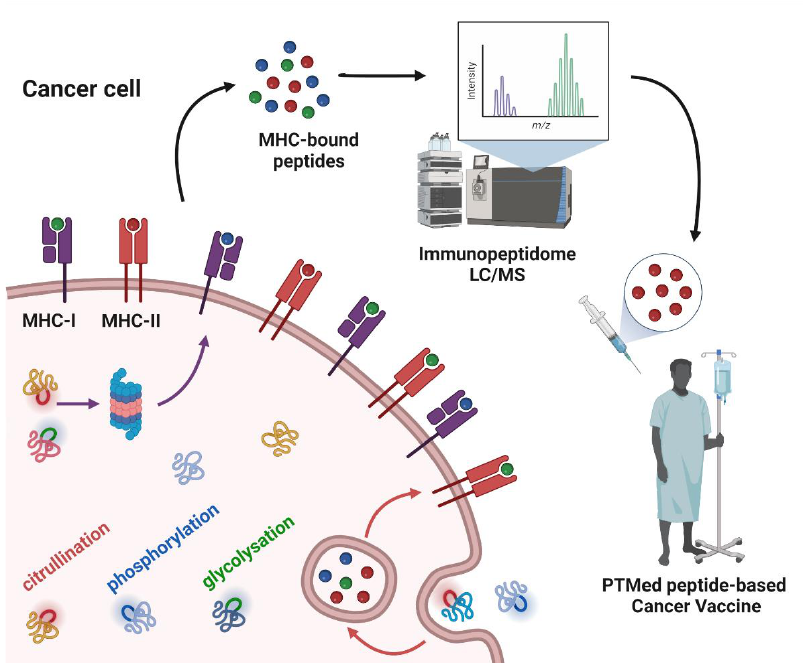
Figure 1. Post-translationally modified peptide-based cancer vaccine workflow. The figure depicts cancer cell antigen processing of intracellular and extracellular proteins, subsequently as peptides bound to MHC-I or MHC-II. Some of the proteins have PTMs in their structure, which are sketched in colors (citrullination: red; phosphorylation: blue; glycosylation: green) as well as in MHC-bound peptides. The MHC-bound peptides are identified by means of liquid chromatography-mass spectrometry (LC/MS), to derive the cancer cell immunopeptidome. From the immunopeptidome data, peptides with PTMs can be selected as antigens for cancer vaccines.